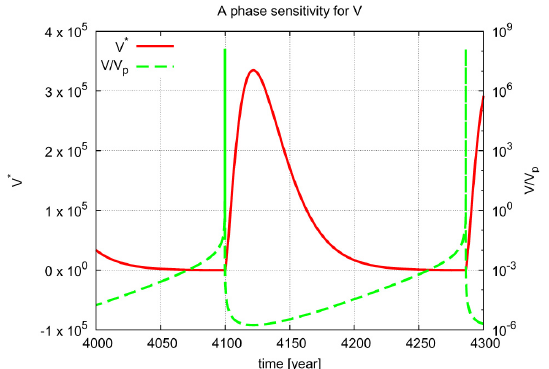
Fig. 9. Phase sensitivity, V ∗ , as a function of time in years (red curve) calculated numerically using the relaxation method. The parameters are set to (k,V p ,g,A,B,L) = (1 . 00 × 10 5 Nm − 3 , 3 . 17 × 10 − 9 ms − 1 , 5 . 00 × 10 6 Nm − 3 s, 1 . 50 × 10 5 Nm − 2 , 2 . 20 × 10 5 Nm − 2 , 1 . 00 × 10 − 2 m). The green curve is for V/V p in a loga-